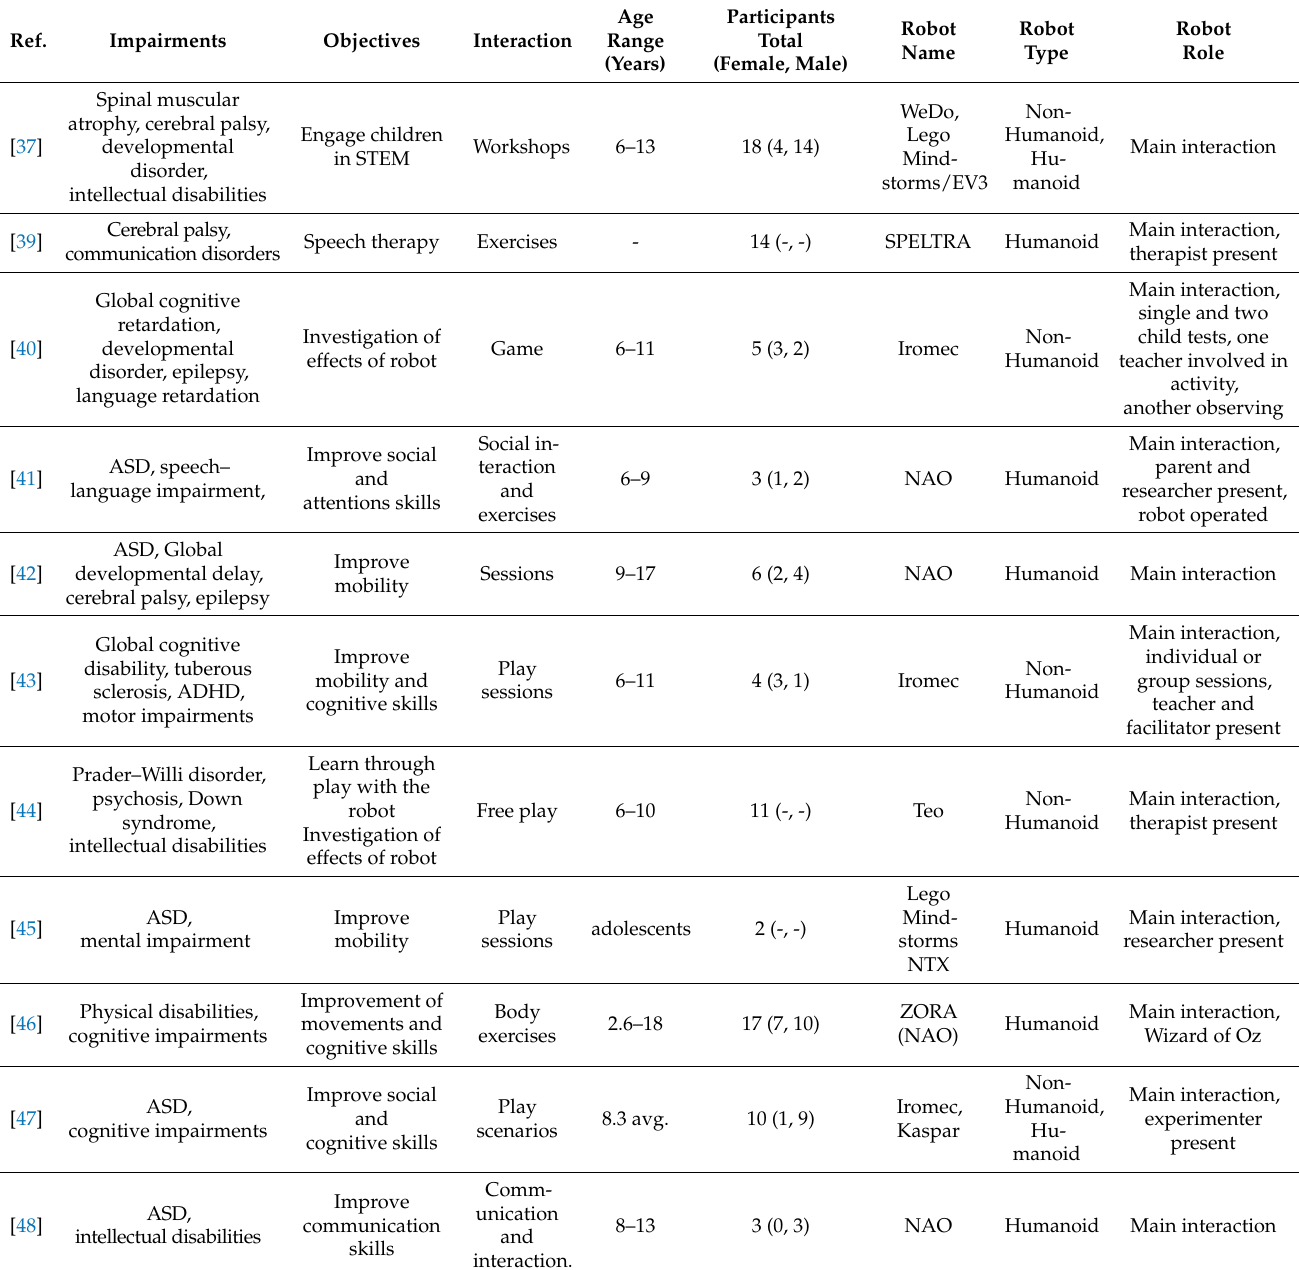
Table 2. Quantitative information of the examined studies with multiple